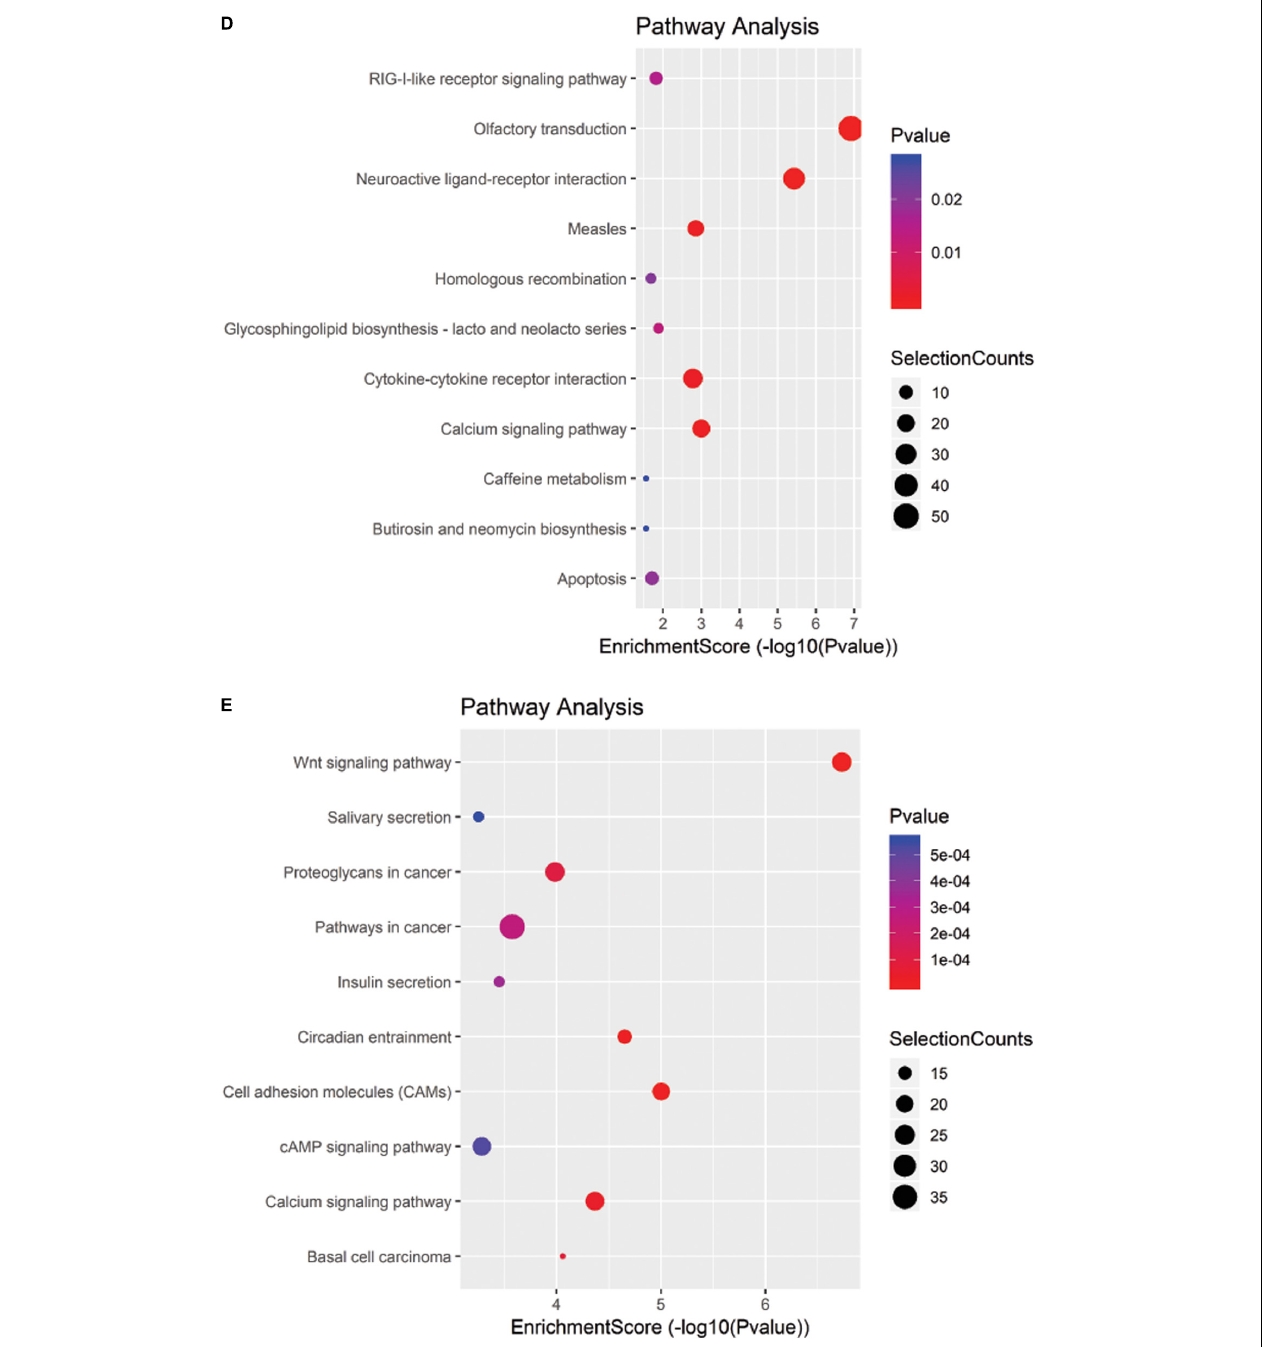
FIGURE 2 | Gene ontology and Kyoto Encyclopedia of Genes and Genomes analyses of coding genes containing altered m 6 A peaks. (A) Comparison of the number of hypermethylated and hypomethylated m 6 A peaks identified in PP, PN, and NN samples. (B) The top 10 gene ontology terms were significantly enriched for the hypermethylated genes in PP vs. NN. (C) The top 10 gene ontology terms were significantly enriched for the hypomethylated genes in PP vs. NN. (D) The top 10 significantly enriched pathways for the hypermethylated genes in PP vs. NN. (E) The top 10 significantly enriched pathways for the hypomethylated genes in PP vs.